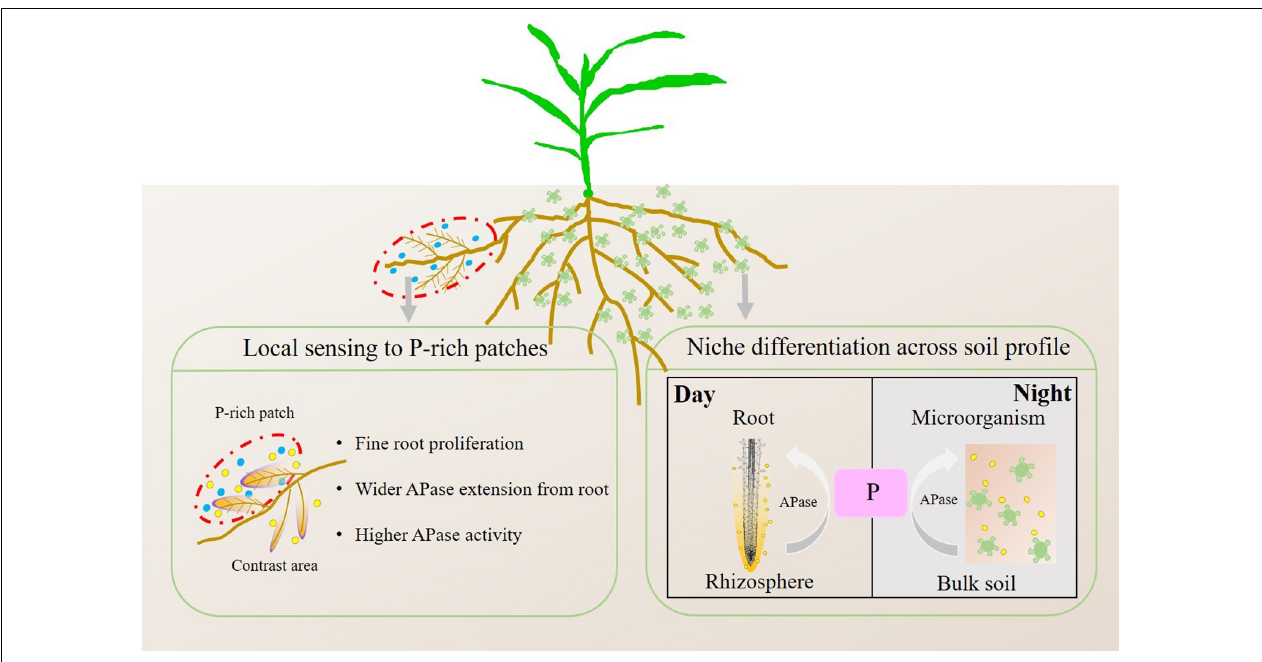
FIGURE 12 | Conceptual model of root growth and APase activity in soil sensing to P-rich patches. The blue circles represent P fertilizer, the yellow circles represent APase secreted by roots and microorganisms, and the green irregular shapes represent